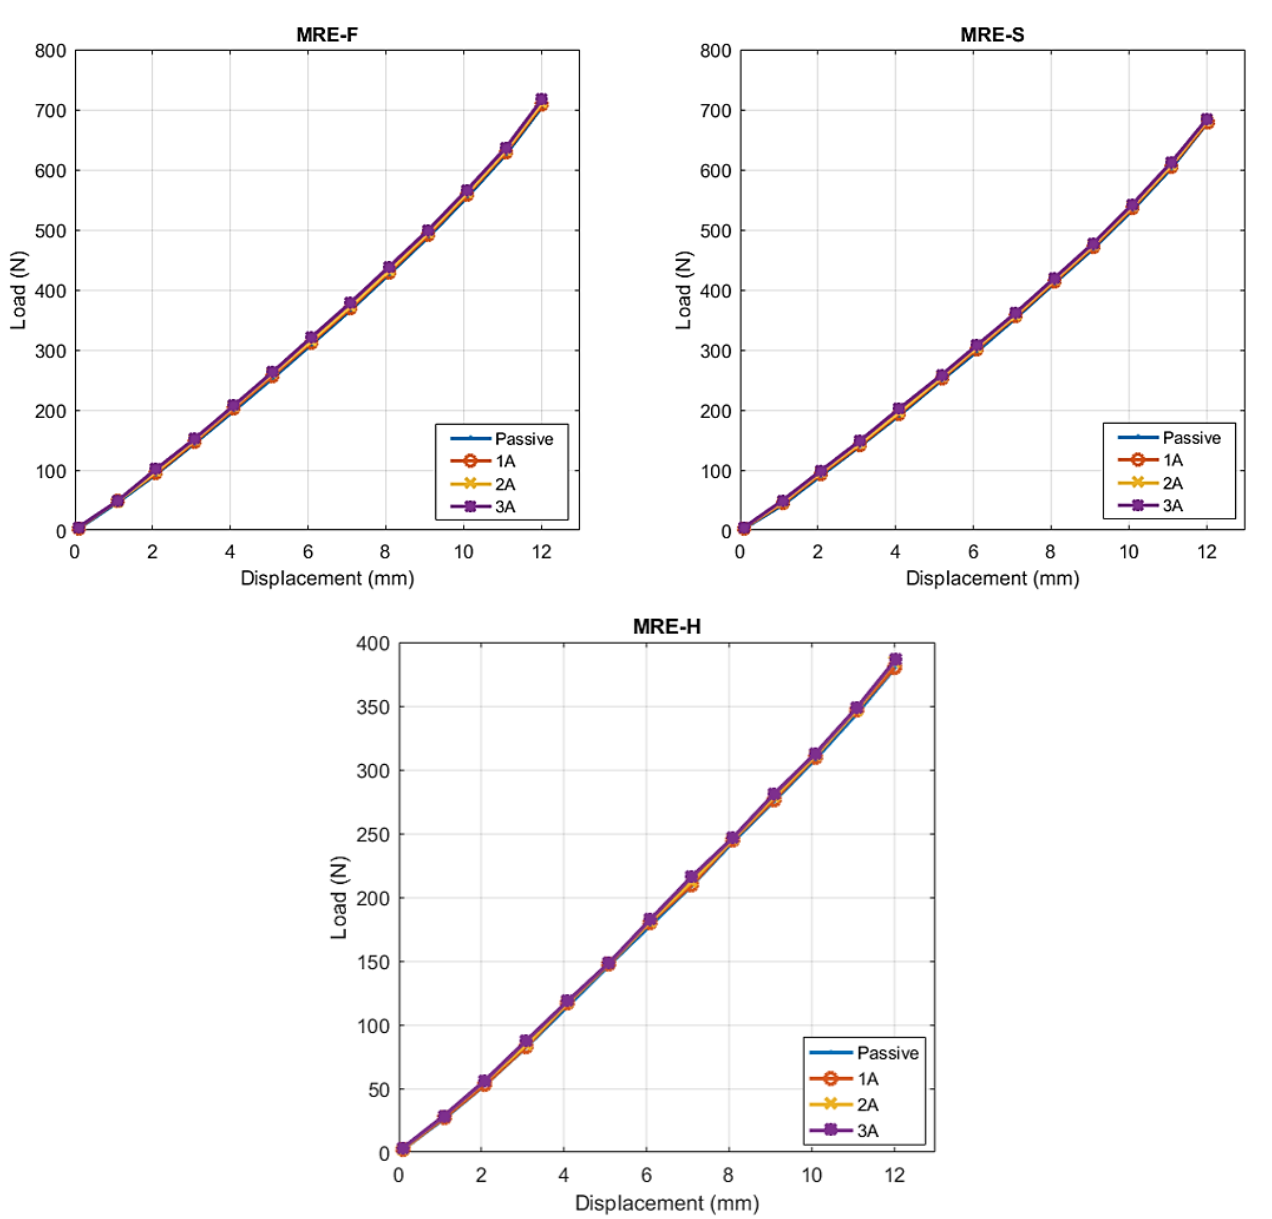
Figure 10. Load-displacement curves for MRE-F, MRE-S, and MRE-H. Table 3. Measured stiffness of MRE-F, MRE-S, and MRE-H at different current values. Applied Current